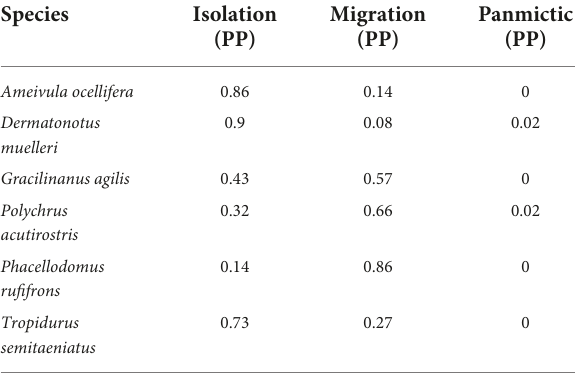
TABLE 4 Posterior probabilities for each model and study species from approximate Bayesian computation (ABC). Species Isolation Migration (PP) (PP)